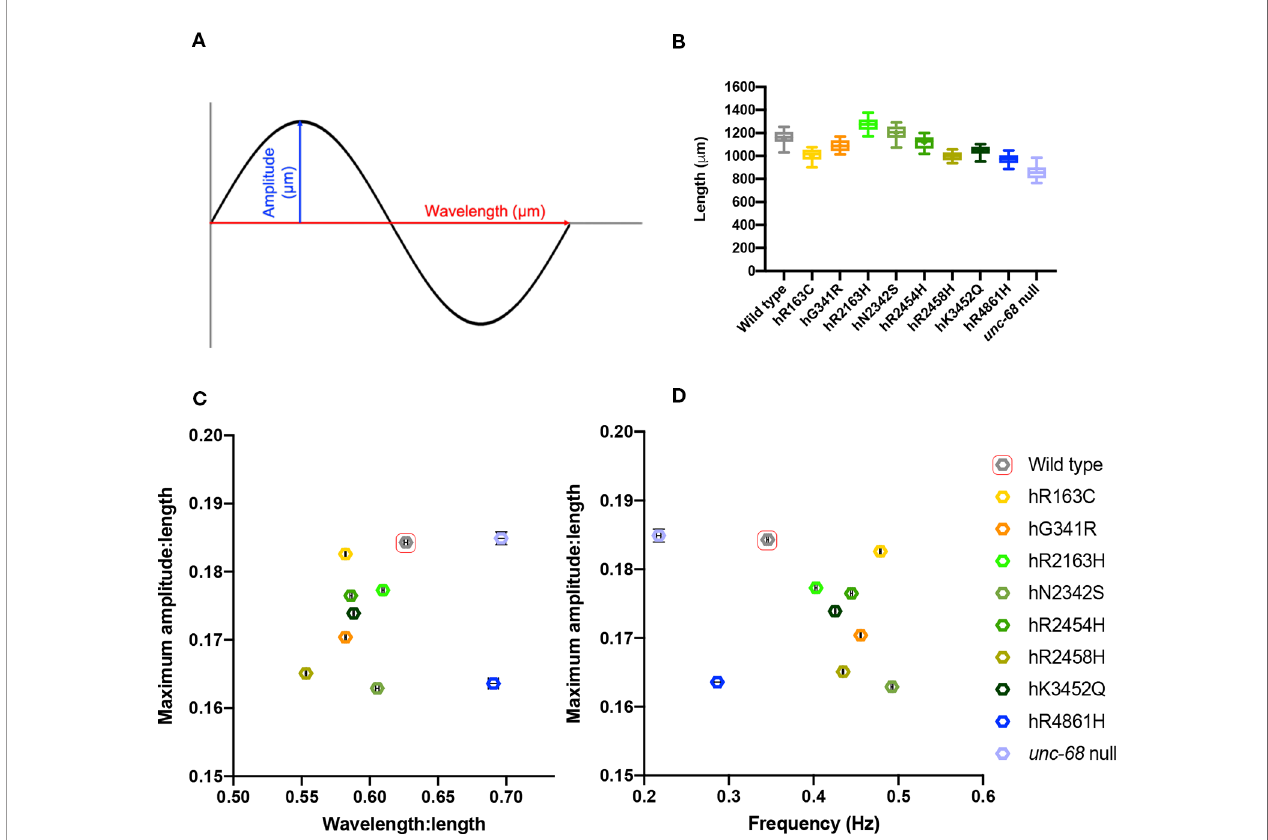
FIGURE 3 | Young adult crawling differences due to ryanodine receptor (RyR) variants. Amplitudes and wavelengths of the crawling wave form (A) were extracted from 1 min long, 25 frames per second, video recordings of 20 – 30 individual young adults, along with worm length and wave frequency. Worm length (B) , maximum amplitude versus wavelength (C) , and maximum amplitude versus frequency (D) for RyR variant strains, labelled by the human variant they correspond to, along with the N2 wild type and the CB540 unc-68(e540 ) null mutant, were compared. Maximum amplitude and wavelength were normalized for worm length. Boxes indicate the median and interquartile range, with whiskers to the 10 – 90 percentile, outliers as dots, and + to indicate the mean (B) . Mean and SEM are indicated, although SEM is very small for frequency and for normalized maximum amplitude and wavelength (C, D)